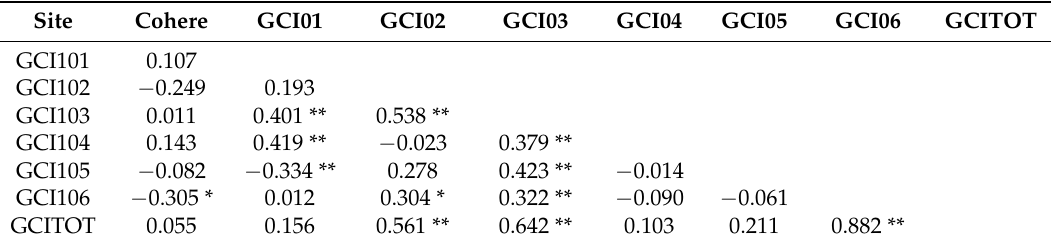
Table 3. Global Coherence App and Global Coherence sites Spearmen correlation matrix.